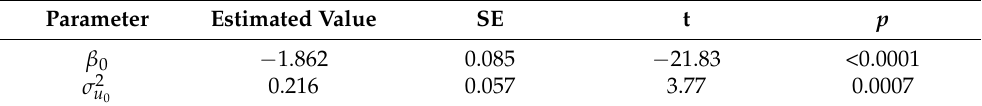
Table 3. Fitting results of two-level logistic random intercept null model.